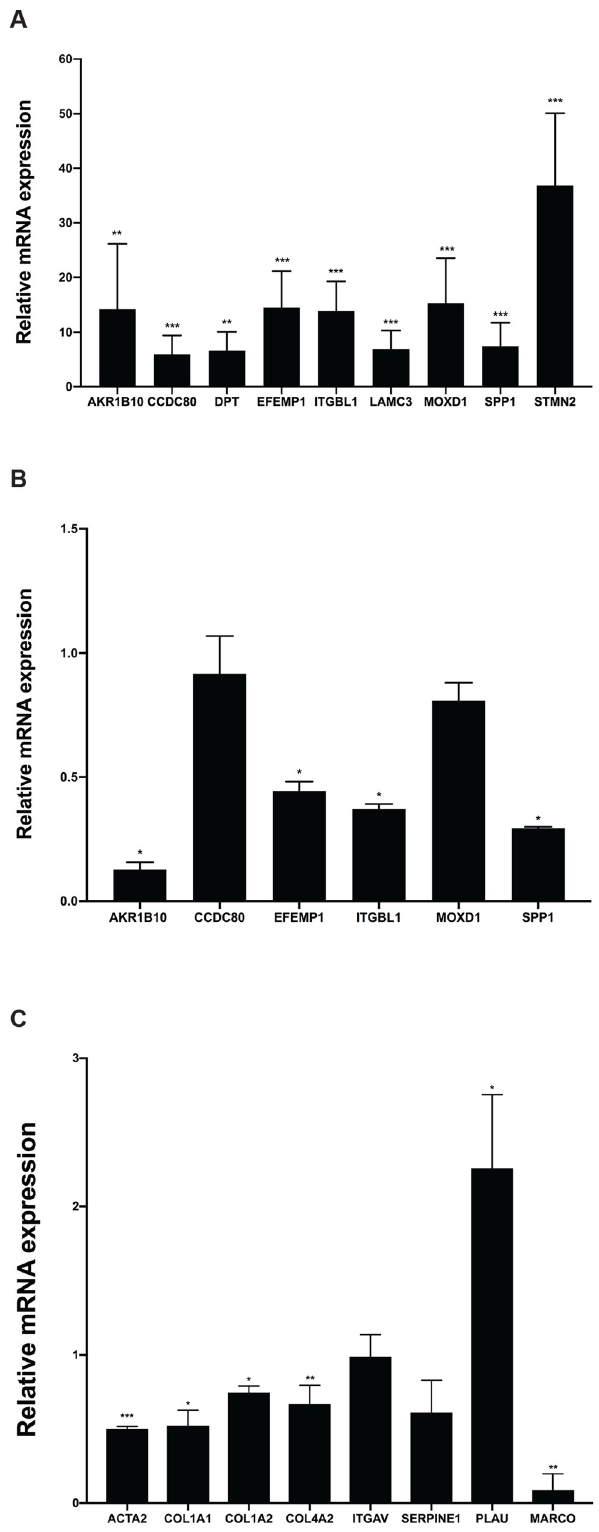
Fig 4. Expression of predicted AEBP1 target genes. A ) We measured levels of the genes of interest using qPCR and hepatic RNA from NAFLD patients with normal liver histology and severe fibrosis. Transcript levels were normalized